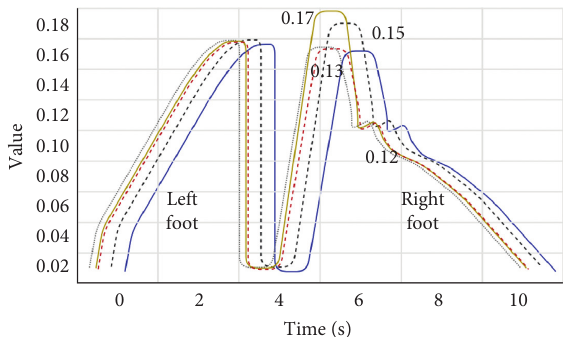
Figure 11: Set different desired foot pressure center position after adjusting the foot pressure curve.